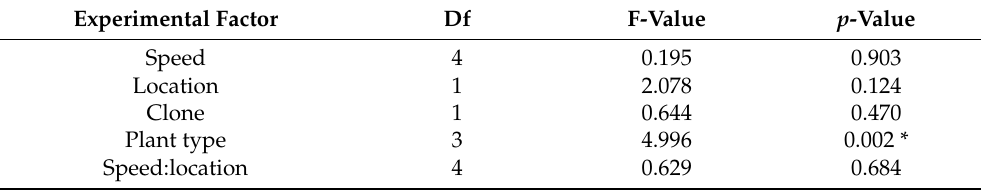
Table 4. Zasso experiment. Effects of the parameters speed, location, clone, plant type, and their interactions on vitality of mother tubers from C. esculentus plants electrocuted with the Zasso device in